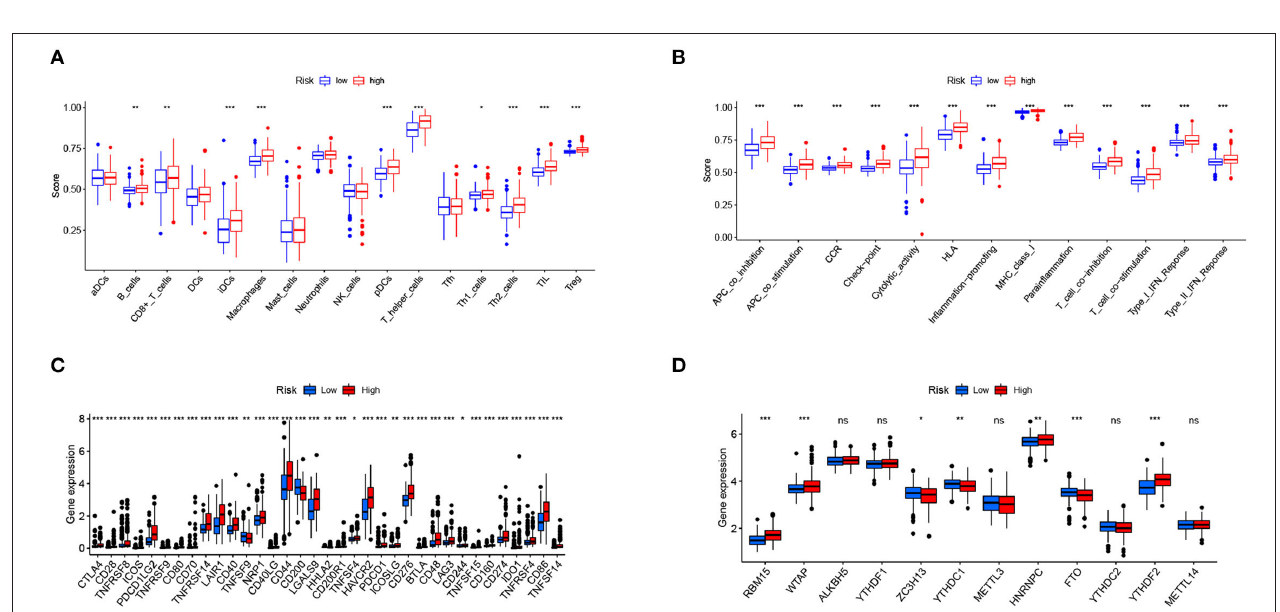
FIGURE 10 | Relationship of the risk signature with immunity and m6A. (A) Scores of immune cell infiltration, (B) immune function activity, (C) immune checkpoint expression, and (D) m6A-related gene expression were compared between the two subgroups. * p < 0.05, ** p < 0.01, *** p < 0.001, ns, no significance.